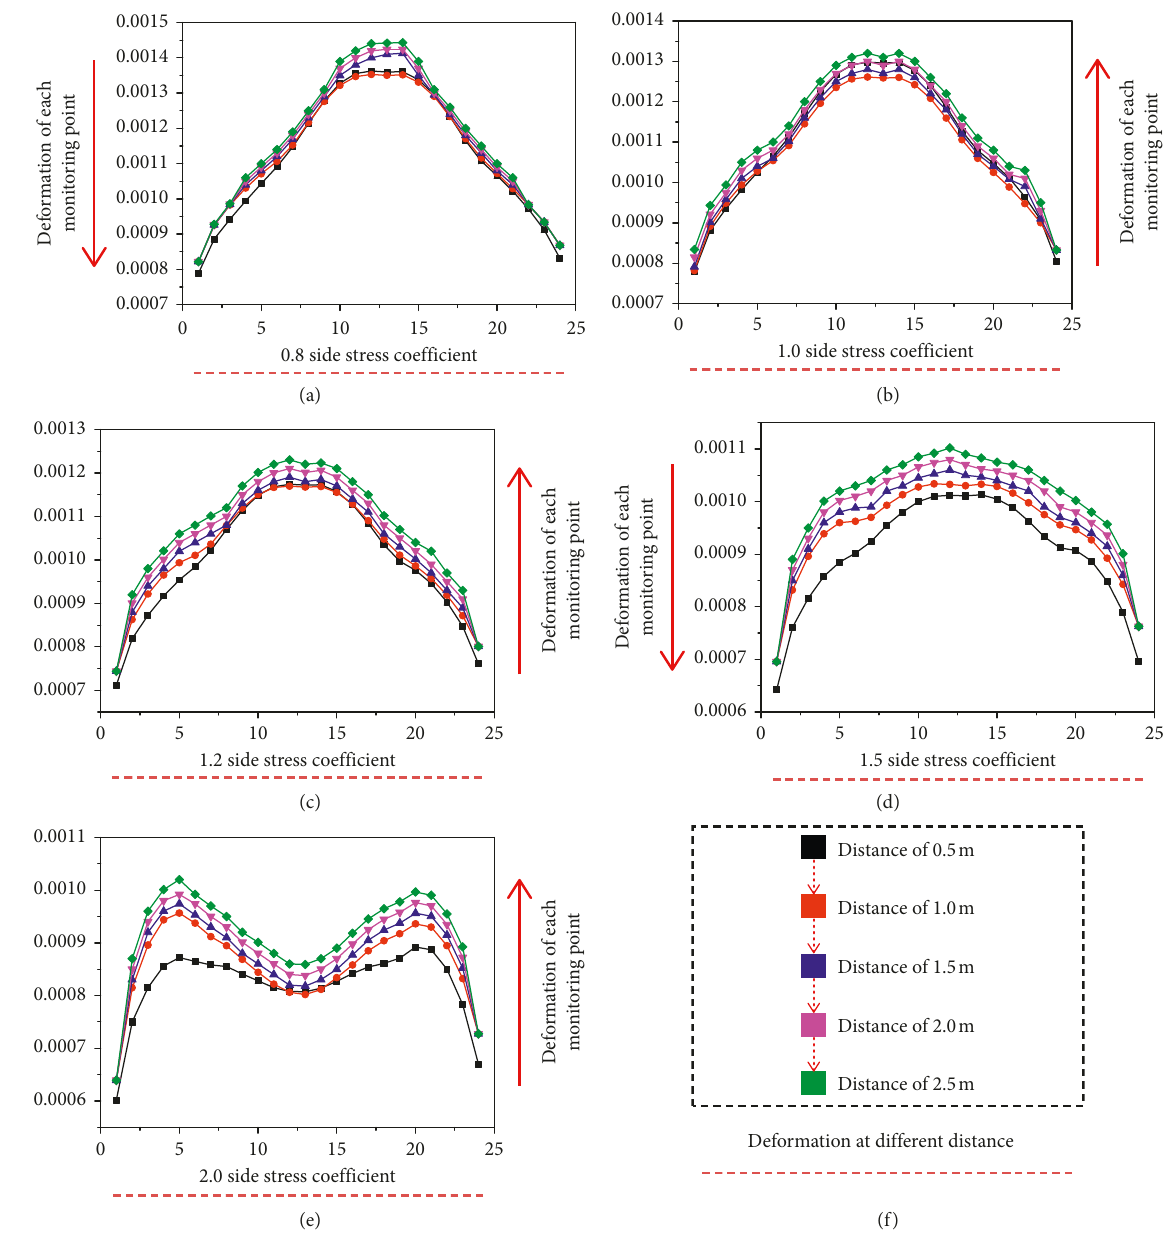
Figure 7: The deformation of various monitoring points with different factors. (a) Deformation of the 0.8 side stress coefficient; (b) deformation of the 1.0 side stress coefficient; (c) deformation of the 1.2 side stress coefficient; (d) deformation of the 1.5 side stress coefficient; (e) deformation of the 2.0 side stress coefficient. The black curve represents the distance of 0.5m; the red curve, the distance of 1.0m; the blue curve, the distance of 1.5m; the pink curve, the distance of 2.0 m; the green curve, the distance of 2.5